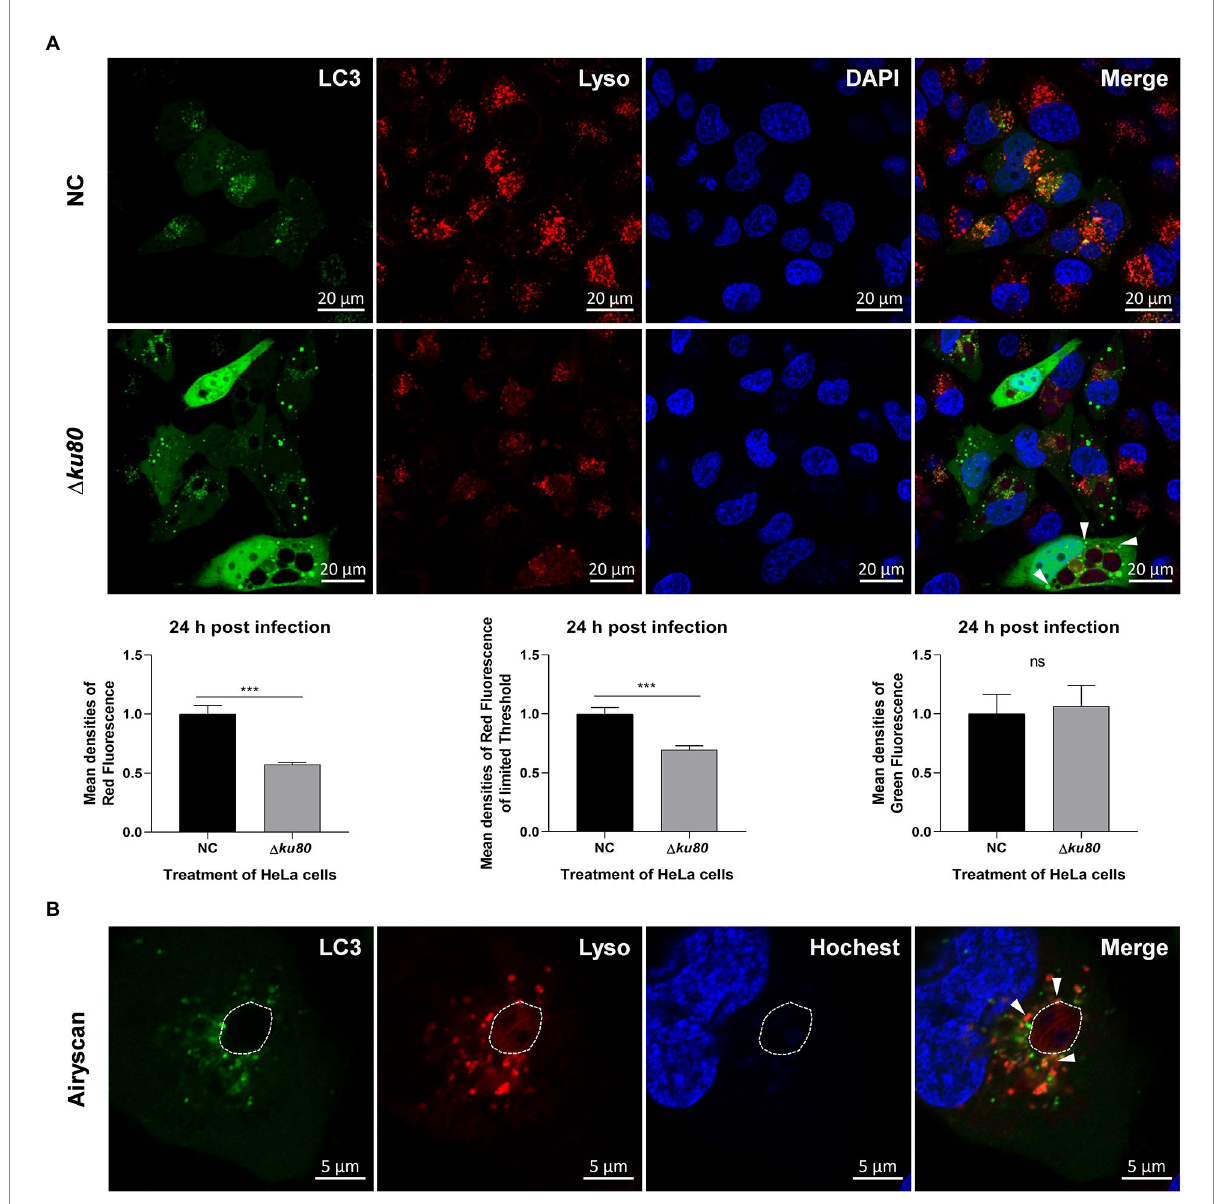
FIGURE 4 The distribution of lysosomes in T. gondii infected HeLa cells. (A) HeLa cells overexpressing EGFP-LC3 were challenged by T. gondii RH ∆ ku80 tachyzoites at an MOI of 2:1, and live cells were stained at 24 h post-infection. The nuclei were stained with Hoechst and lysosomes with Lyso- Tracker Red. The fluorescence signals were collected within 40 min after staining ( ∆ ku80 ). N: uninfected control cells. Quantitative analysis of fluorescence was done using Image J. Mean density of single fluorescence of each merged image was measured after channels splitting, each value is the mean ± SEM of 6 microscope fields (*** p ≤ 0.001; t-tests). (B) The parasite PVM was outlined with a dashed line, and LC3 recruited to the PVM was indicated by